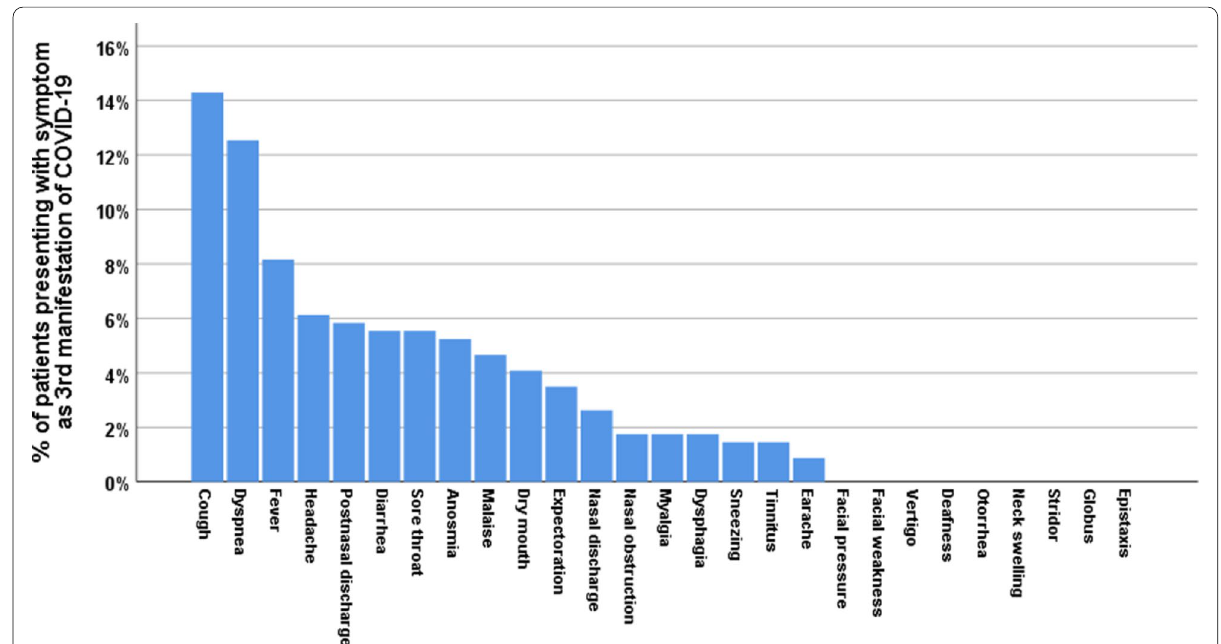
Fig. 4 Percentage of patients presenting with various symptoms (ORL, non-ORL) as third manifestation of COVID-19